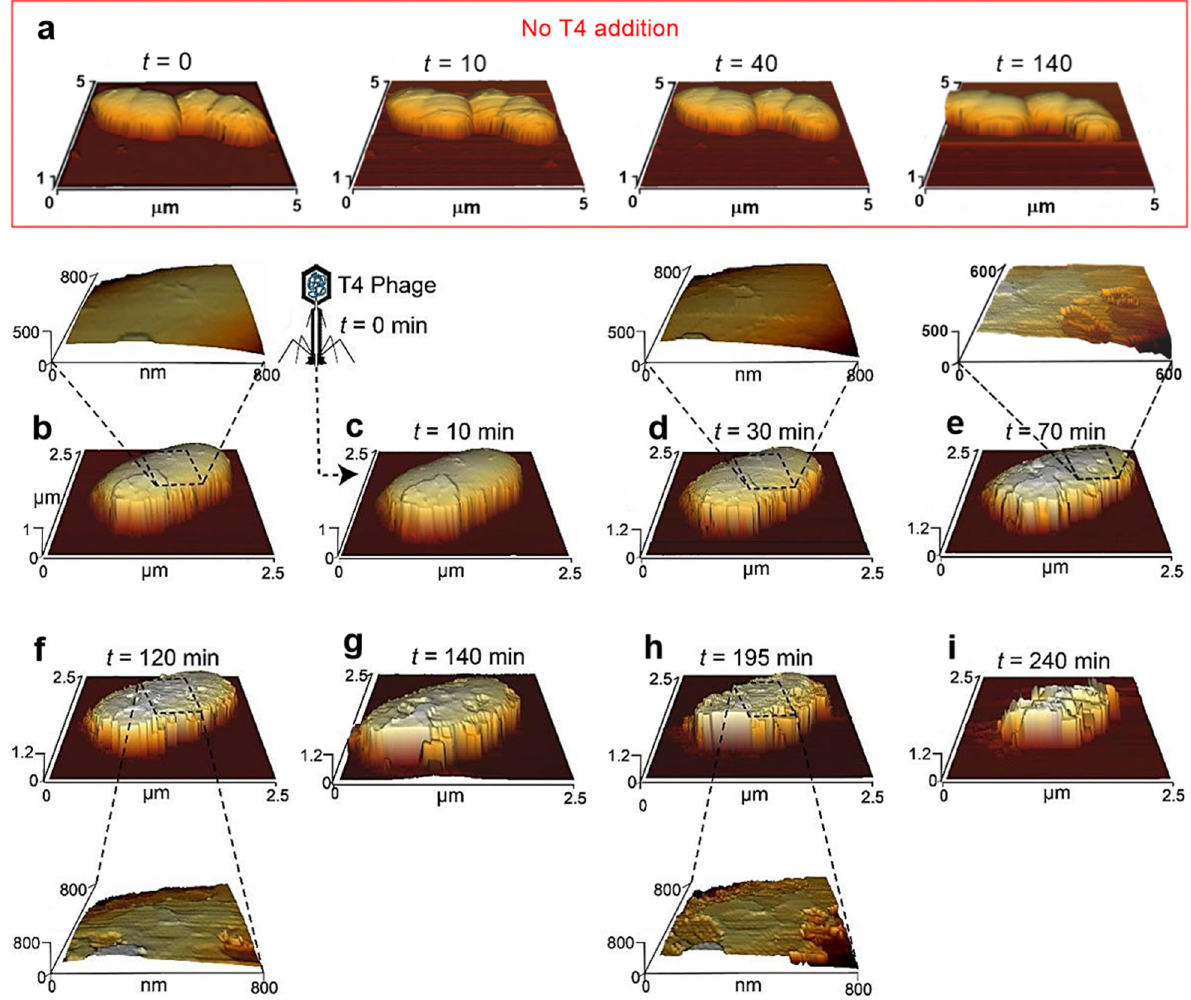
Fig. 3 Three-dimensional, time-series images of an E. coli cell during T4 phage infection captured in situ by AFM. a Images of uninfected E. coli cells, namely with no addition of T4. b The fi rst image was captured before the addition of T4 phages, de fi ned as t = 0. c – i Time series of AFM images that show the changes in nanotopography of the same cell during the infection cycle under hydrated conditions. Representative sections were enlarged to identify distinct nanostructures at different time points ( b , d , e , f , h ). Similar images were captured from 12 other cells at 5 individual